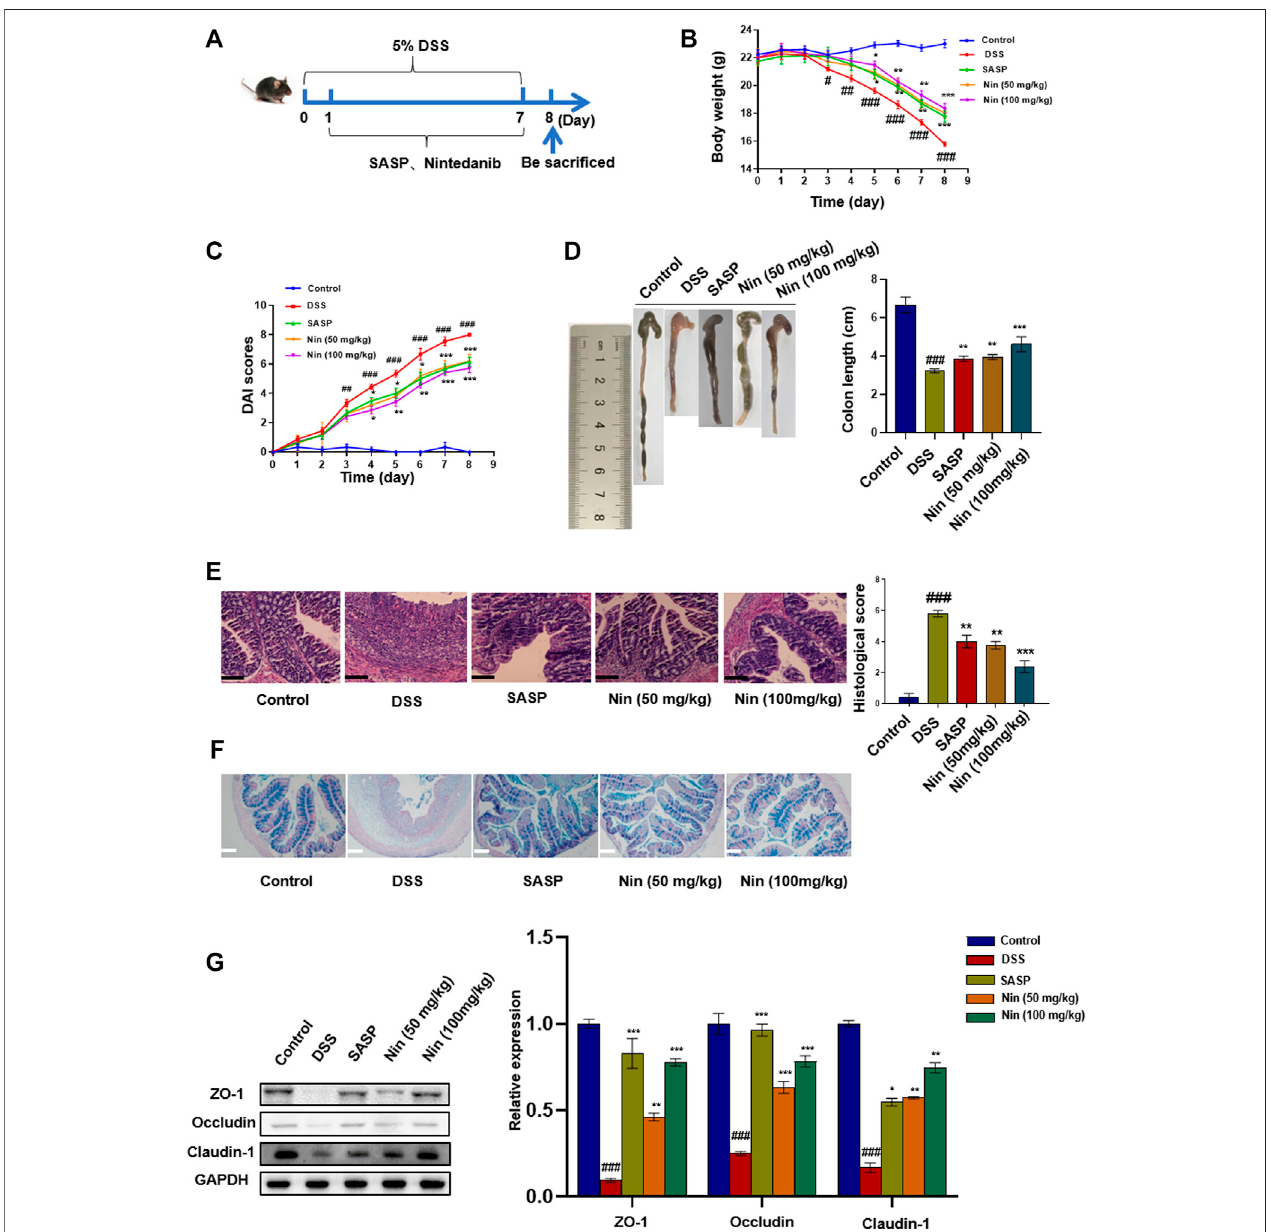
FIGURE 4 | Effect of nintedanib on DSS-induced experimental colitis in mice. (A) 5% DSS-induced experimental colitis in mice. Effects of nintedanib on weight change (B) ,theDAIscore (C) ,and colonlengthchange (D) in experimental colitismice. (E) Histologicalsections ofcolonic tissue stainedwithhematoxylinand eosinare shown using a microscope. Scale bars represent 50 μ m. (F) Representative images of Alcian blue-stained inner mucus layer of colonic sections. Scale bars represent 50 μ m. (G) The effect of nintedanib on the expression of intestinal epithelial barrier proteins ZO-1, occludin, and claudin-1. Data are presented as the mean ± SD ( n = 5). ## p < 0.01, ### p < 0.001, signi fi cantly different from the control group; *p < 0.05, **p < 0.01, ***p < 0.001, signi fi cantly different from DSS